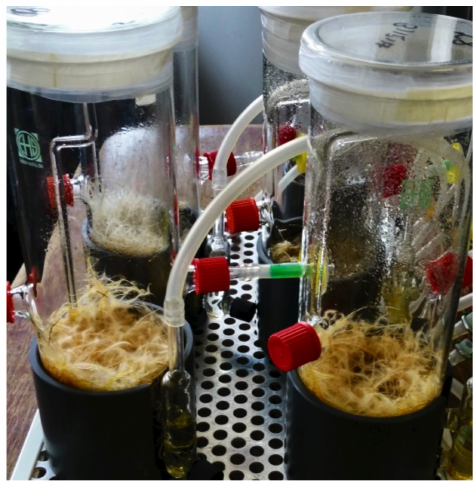
Figure 5. HPLC analysis of root exudates of rose ( Rosa canina L.) collected in the bioreactor. ( A ) HPLC chromatogram of root exudates separated on a reverse-phase column, eluted with a methanol gradient and detected by light absorption at 254 nm. ( B ) UV absorption spectra of major phenolic compounds recorded using a diode array detector coupled to HPLC.